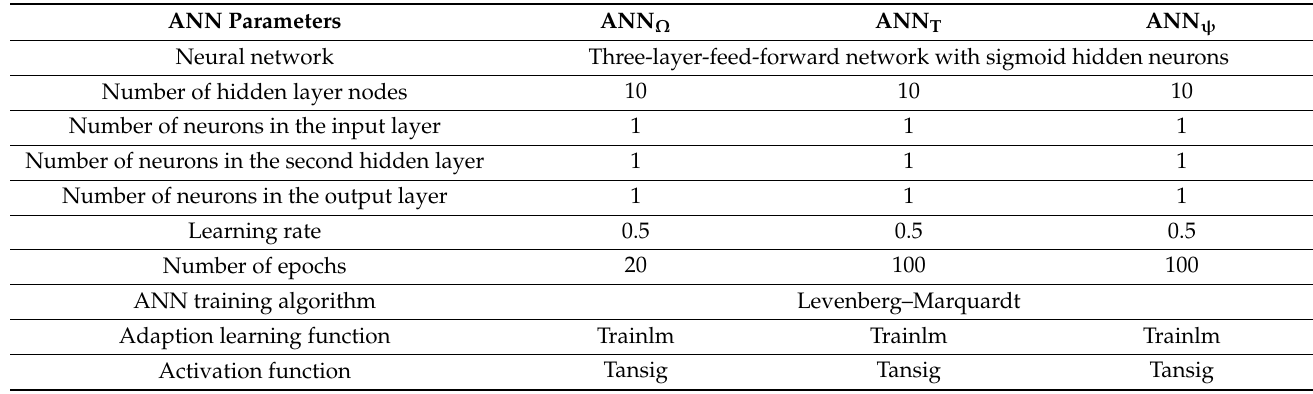
Table 2. Specification of the optimum proposed ANN models, values and methods.